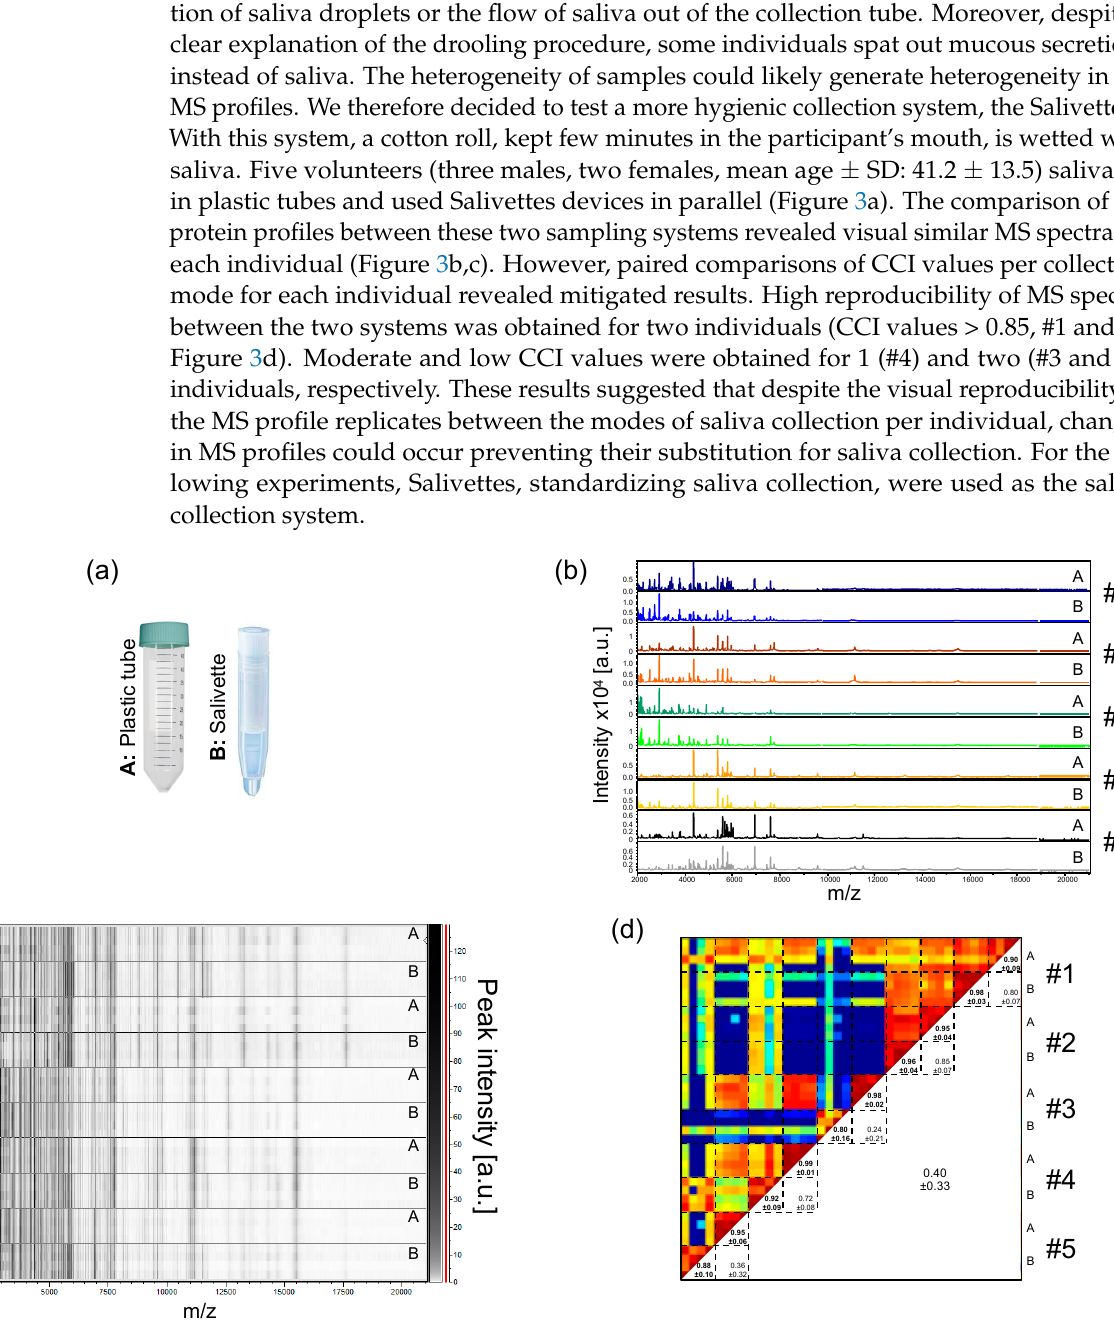
Figure 3. Comparison of saliva MS profiles from healthcare workers collected with two distinct systems. ( a ) Representation of the two saliva collection systems used. (A) Plastic tube; (B) Salivette ® . ( b ) Representative saliva MS spectra collected either directly in plastic tube (A) or in a Salivette system (B) from five healthcare workers. ( c ) Gel view of the saliva MS profiles from the same five healthcare workers. The four replicates loaded on the MS plate for each individual per saliva collection system are presented. The gray scale in the right part of the panel correspond to the MS peak intensity level in arbitrary units (a.u.). ( d ) Composite correlation index (CCI) matrix representing the levels of MS spectra reproducibility between saliva samples. CCI are expressed as the mean ± standard deviation. #1 to #5: healthcare workers.